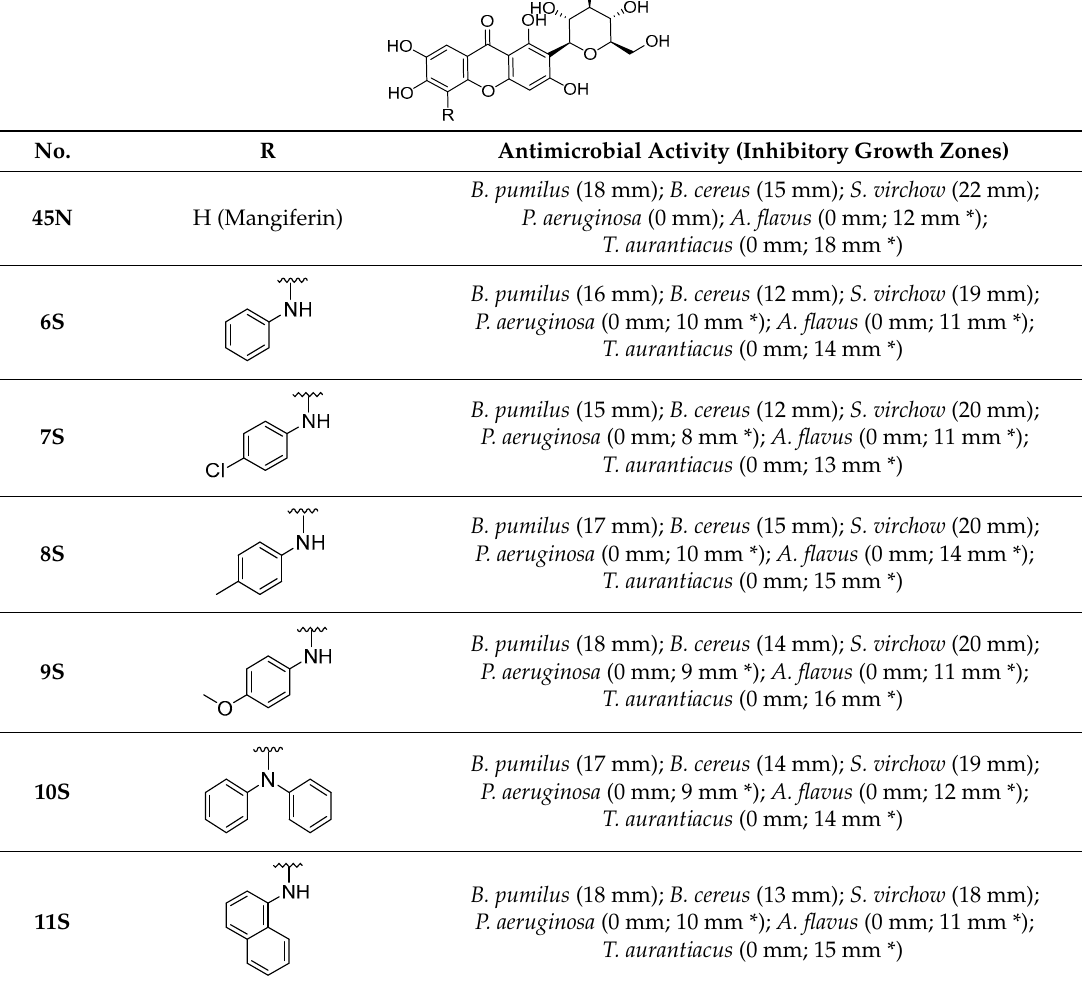
Table 8. Antimicrobial activity of mangiferin analogues.